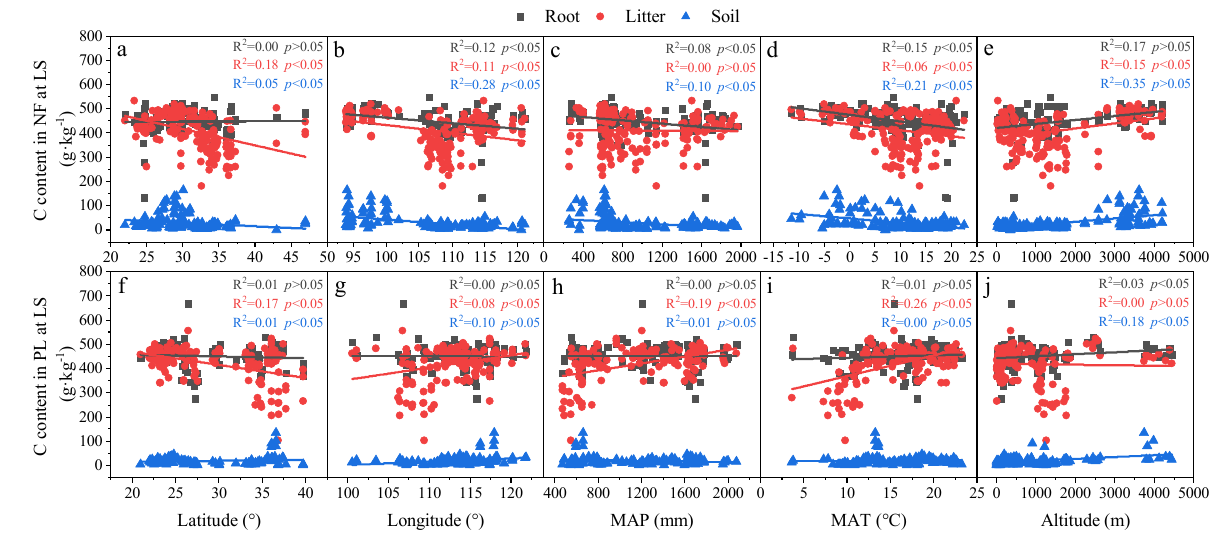
Figure A3. C content changes with latitude ( a , f ), longitude ( b , g ), mean annual precipitation (MAP) ( c , h ), mean annual temperature (MAT) ( d , i ) and altitude ( e , j ) in different forest origins in the late stage (LS). The number of forest sites are 114 and 144 for NF − LS and PL − LS, respectively.